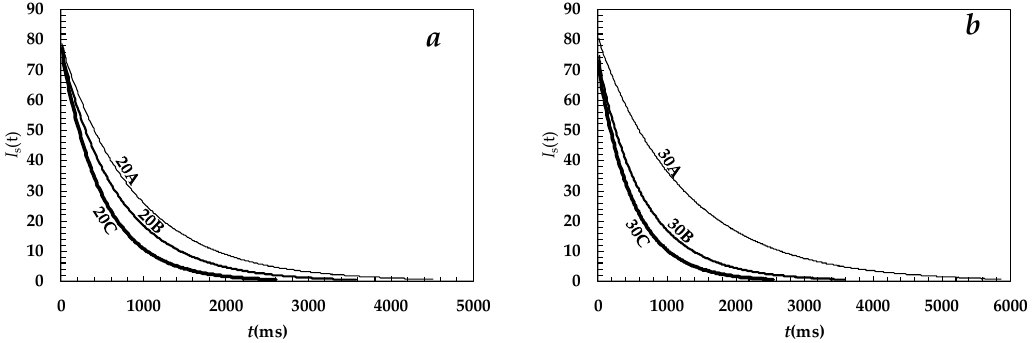
T 22 ) are always necessary to describe the hydrogen relaxation of the six specimen studied.